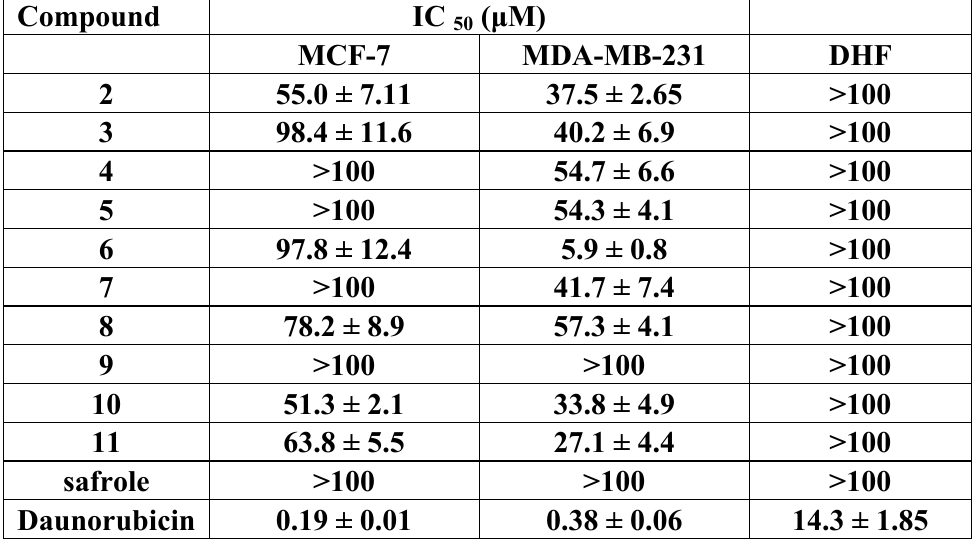
Table 1. Cytotoxic activity of synthesized derivatives safrole compounds against two breast cancer cell lines, MCF-7 , MDA-MB-231 and a dermal human fibroblast cells, DHF, expressed as inhibitory concentration IC 50